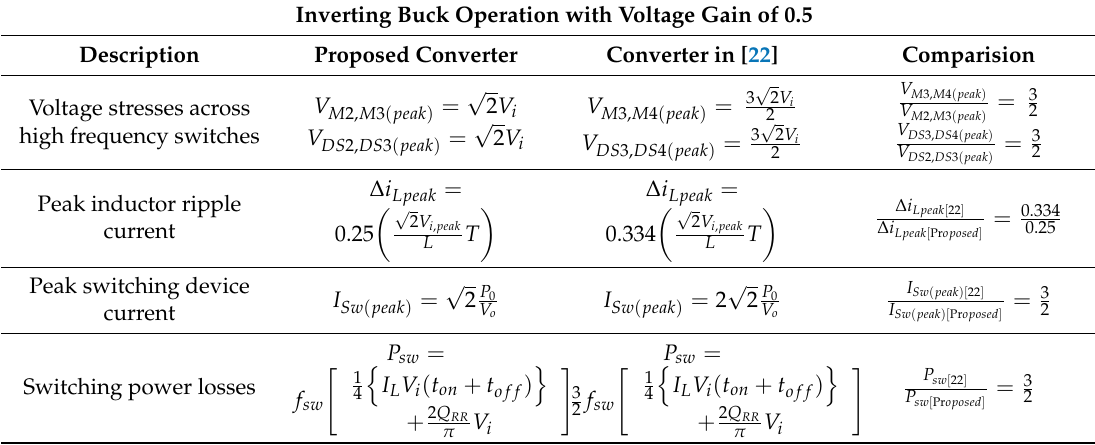
Table 3. Comparison of performance parameters in buck mode.